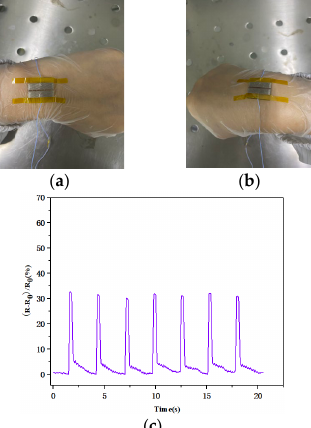
Figure 13. ( a ) The wrist joint in a straight state; ( b ) the wrist joint in a bending state; ( c ) real-time response graph for the flexible pressure sensor attached to the wrist.